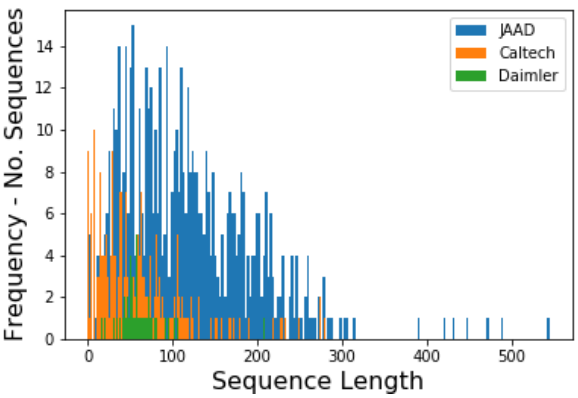
Figure 4. Distribution of sequence length on pedestrian